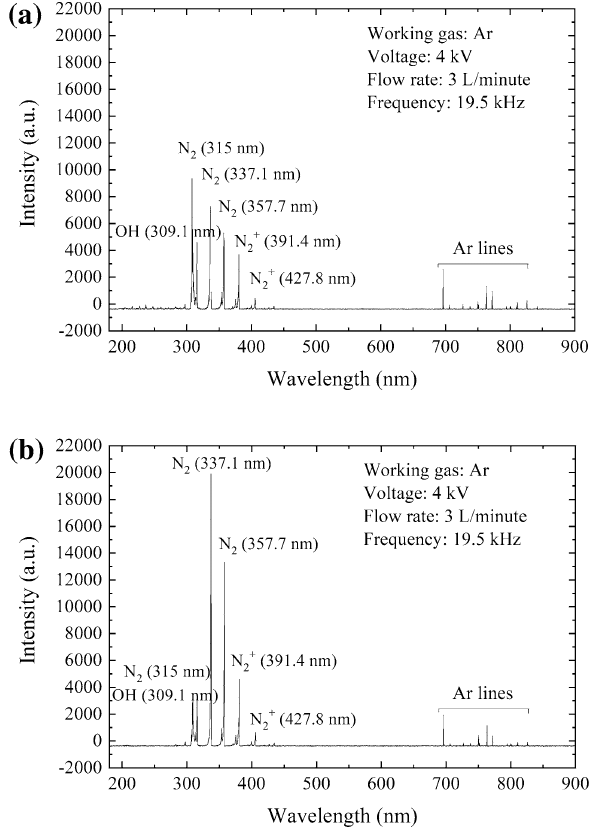
Figure 2. OES of free NTAPPJ in air ( a ) and 2 mm above the NTAPPJ–liquid interface ( b ).